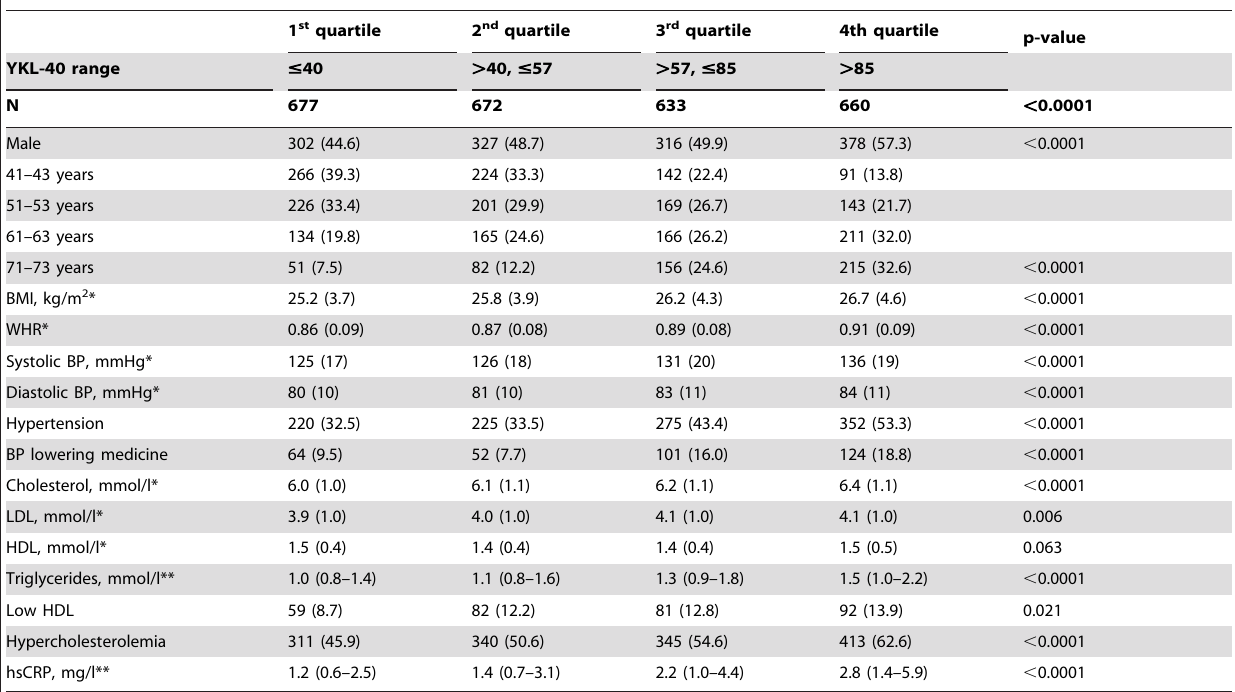
Table 1. Characteristics at baseline according to YKL-40 quartiles in